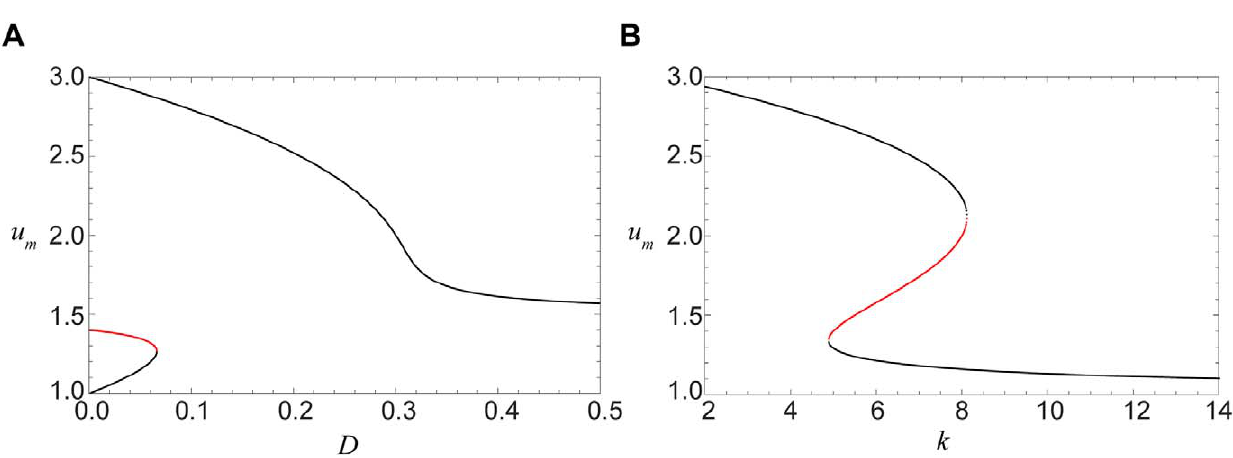
Figure 6. The roots of Eq. (7). The roots u m are plotted as functions (A) of the diffusion constant D for k ~ 4 and (B) of the degree k for D ~ 0 : 1 . Pinned fronts correspond to red parts of the curves. The model parameters are r 1 ~ 1, r 2 ~ 1 : 4 and r 3 ~ 3 .